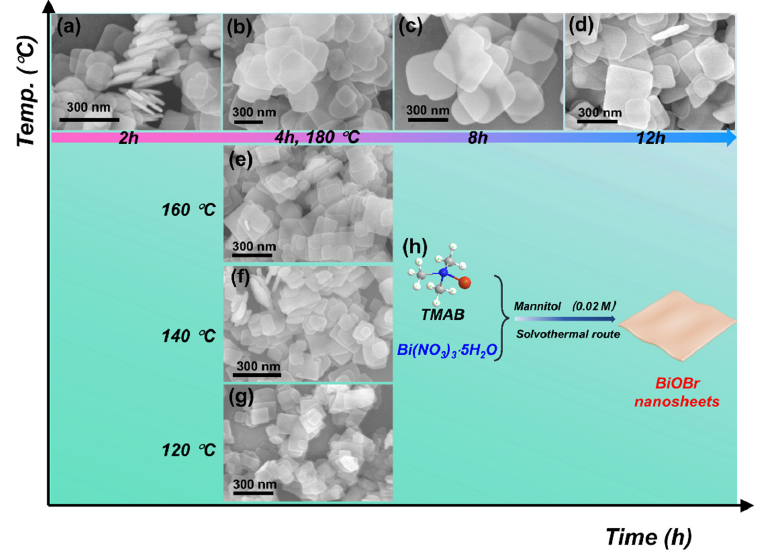
Figure 5. SEM images of the products obtained at different times when the reaction temperature was fixed at 180 ◦ C: ( a ) 2 h, ( b ) 4 h, ( c ) 8 h, and ( d ) 12 h. SEM images of the products obtained at different temperatures when the reaction time was fixed at 4 h: ( e ) 160 ◦ C, ( f ) 140 ◦ C, and ( g ) 120 ◦ C. ( h ) Schematic illustration of the synthetic